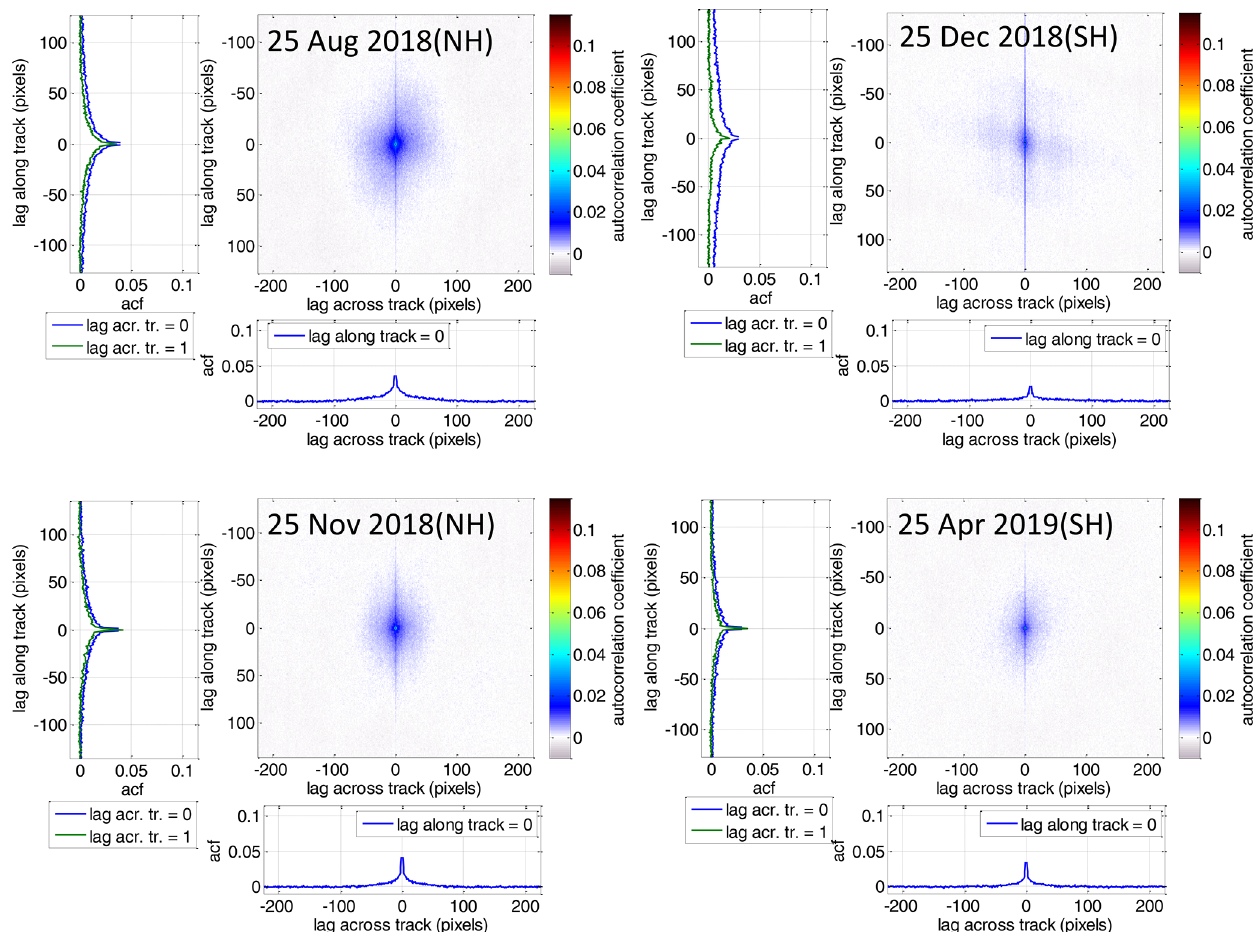
Figure 2. Left: mean autocorrelation coefficients of orbital slices with across-track scans taken at SZAs between 60 and 75 ◦ for days without enhanced OClO as indicated in the respective colour plots. On the left and bottom of each colour plot the coefficients are plotted as line plots for the lag across track of 0 and 1 pixel and lag along track of 0, respectively. The values for both lags being zero are excluded (it is unity by definition). Note that the axis limits are selected to be in the same range as for the plots for the sensitivity studies with different retrieval parameters in Appendix